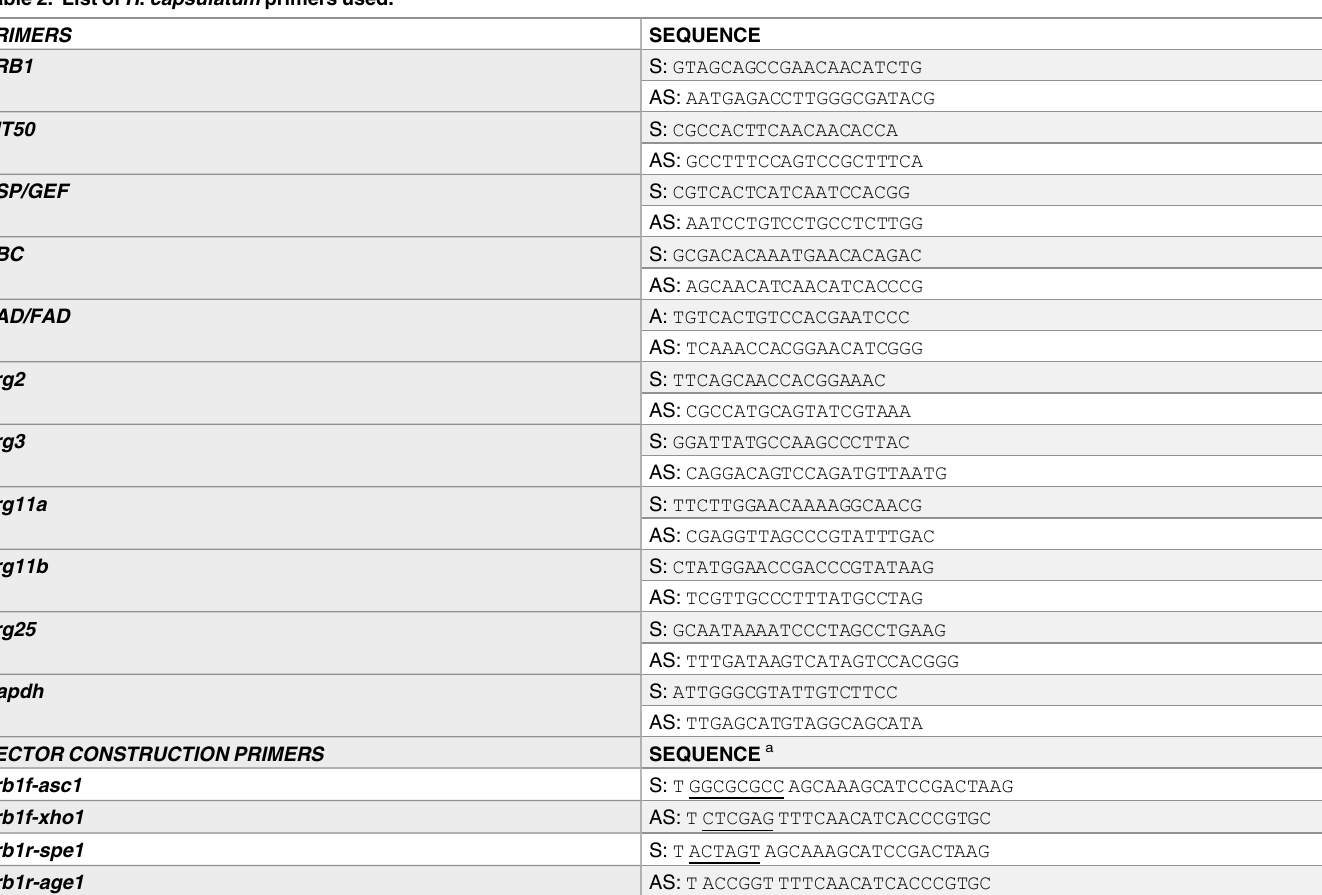
Table 2. List of H . capsulatum primers